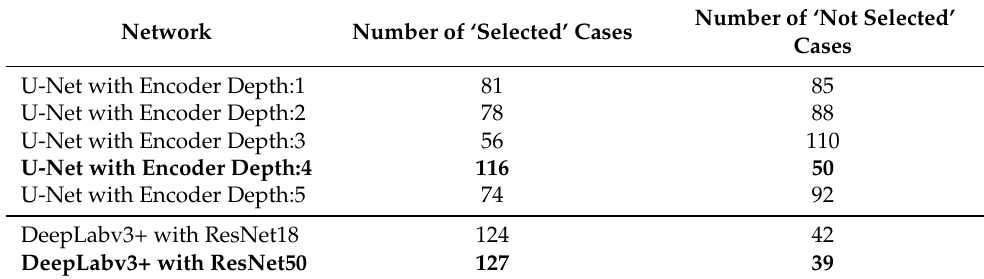
Table 5. Distribution of labeled 166 CR partition used to train the selector classifier for Trial 1. The rows corresponding to each type of network that performed the best during Trial 1 are marked in bold. Network Number of ‘Selected’ Cases